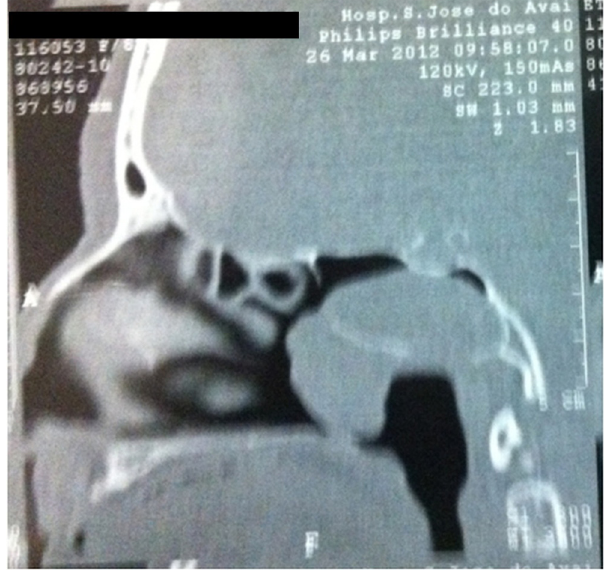
Figure 1 Paranasal sinus tomography showing a sphenoid sinus tumor extending into the